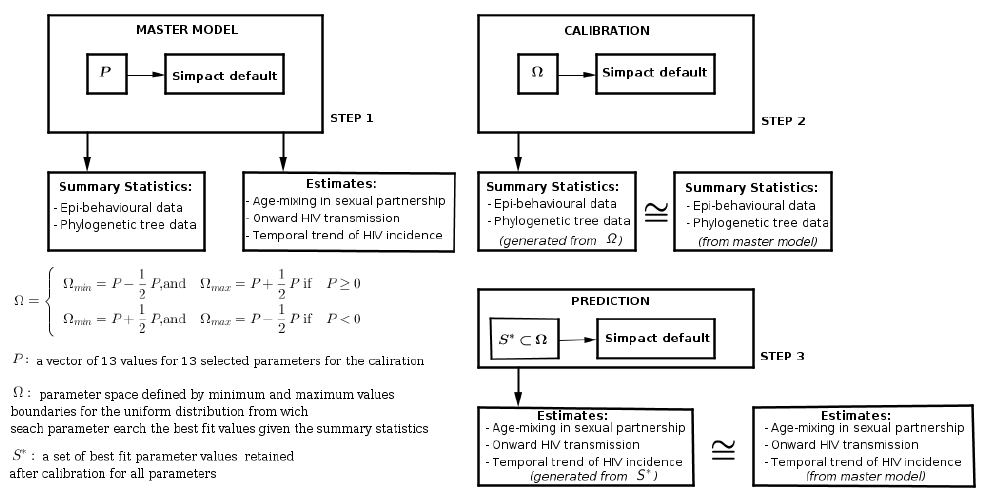
Figure 3. Work-flow with the main steps for the calibration simulation study. The first step is to generate the benchmark data set with selected parameter values. The second step is the calibration of the default modelling framework. The third step is to run the modelling framework using retained parameter values from